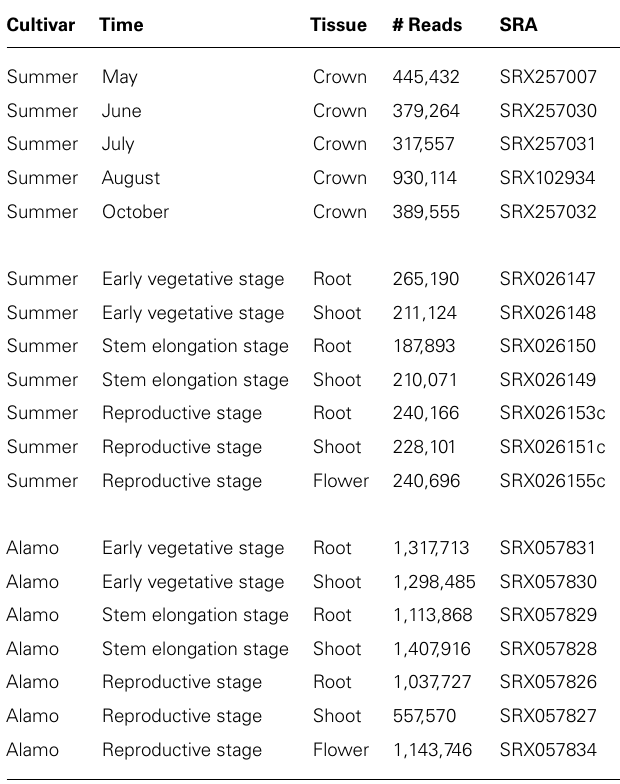
TableA1 | Switchgrass NGS